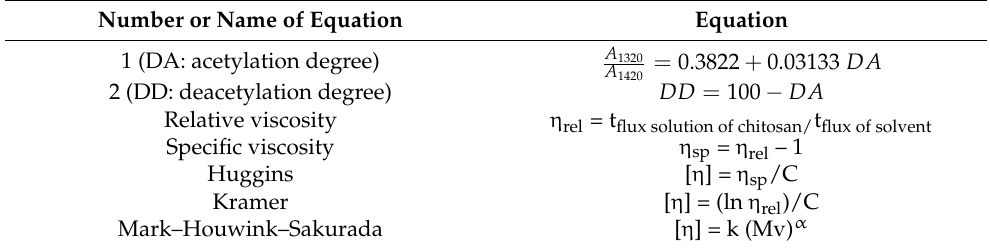
Table 5. Equations for determining the deacetylation degree and molecular weight of